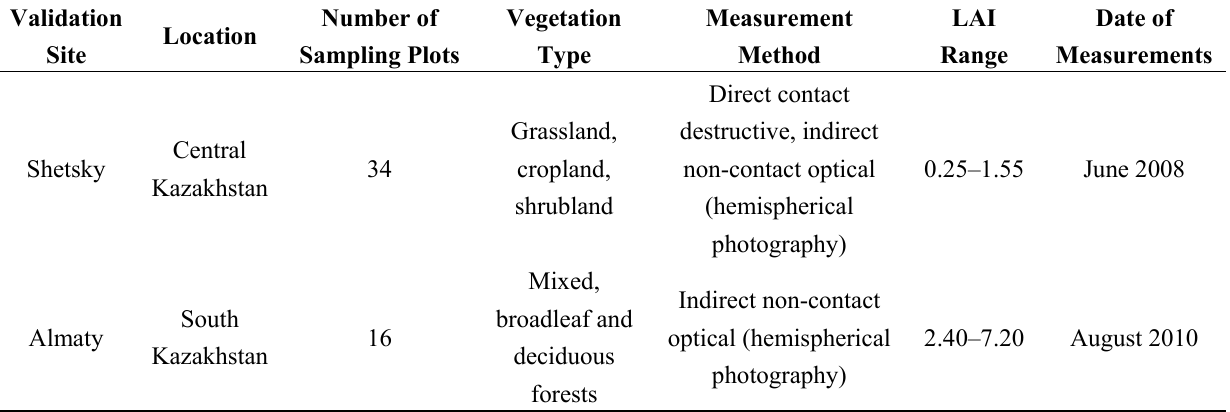
Table 3. Basic characteristics of the test sites that are used for the validation of the LAI3g versus the LAI GGRS